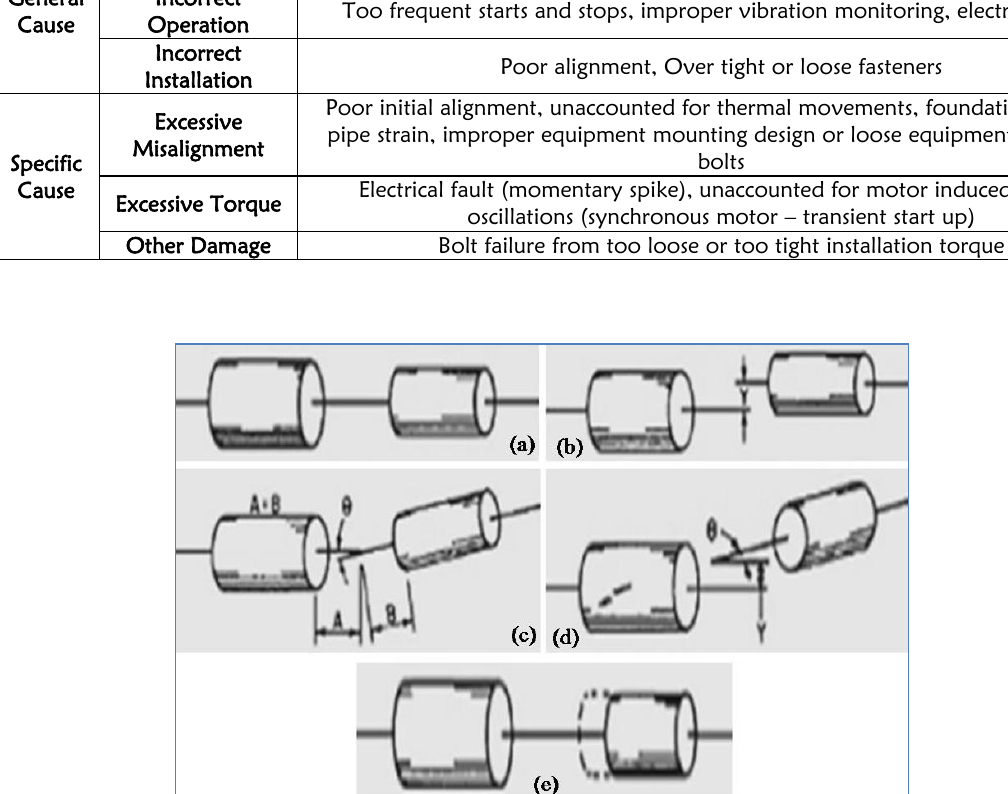
Fig. 1: Proper alignment and various misalignment types: (a) alignment, (b) parallel offset misalignment, (c)